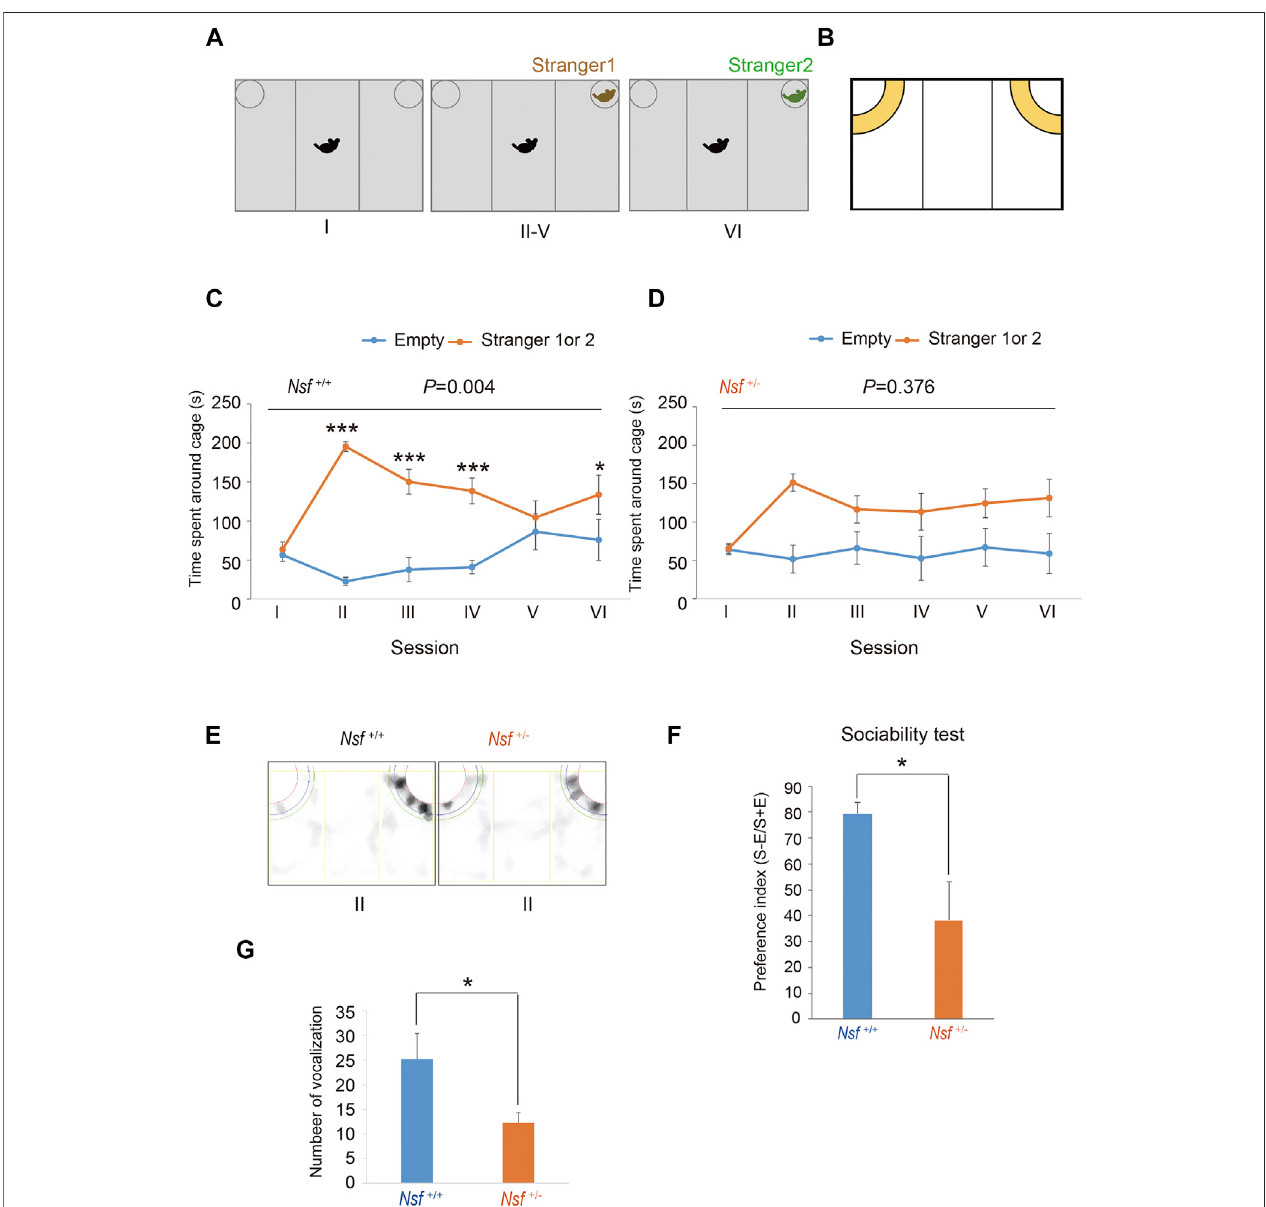
FIGURE 2 | De fi cits in social interaction and communication in Nsf +/ − mice. (A) Schematic representation of three-chamber social interaction tests. Session I: the subject mouse was placed in the middle chamber without any stimulants. Session II – V: stranger 1 was placed inside a cage located in one of the chambers. Then, the subject mouse was placed at the center of the middle chamber. The subject mouse investigated the same stimulant (stranger) mouse during each of the four sessions (II – V).SessionVI:stranger2,insteadofstranger1,wasplacedinsidethesamecageassessionII-V.Then,thesubjectmousewasplacedatthecenterofthemiddle chamber.Thesubjectmousemovedfreelyinthethreechambersfor5 minforeachsession. (B) Yellowrepresentsthevirtualinteractionareasnearcages. (C) Timespent aroundcageswith “ stranger1or2 ” or “ Empty ” by Nsf +/+ miceduringsessionsI – IV( n (cid:1) 13,mean ± SEM.Two-wayrepeatedmeasuresANOVA, p (cid:1) 0.004,Tukey ’ spost hoc test, *** p < 0.001, * p < 0.05). (D) Time spent around cages with “ stranger 1 or 2 ” or “ Empty ” by Nsf +/ − mice during sessions I – IV ( n (cid:1) 13, Mean ± SEM. Two-way repeated measures ANOVA, p (cid:1) 0.376). (E) Representative mount-graph of each genotype during session II. (F) The preference index of the sociability ( n (cid:1) 13 for each genotype, mean ± SEM. Wilcoxon/Kruskal-Wallis test, * p < 0.05). (G) Number of ultrasonic vocalizations emitted by postnatal day 6 pups of each genotype during a 10 min separation from their mother ( n (cid:1) 26 in Nsf +/+ mice and n (cid:1) 20 in Nsf +/ − mice, mean ± SEM. Spearman ’ s rank-order test, * p <